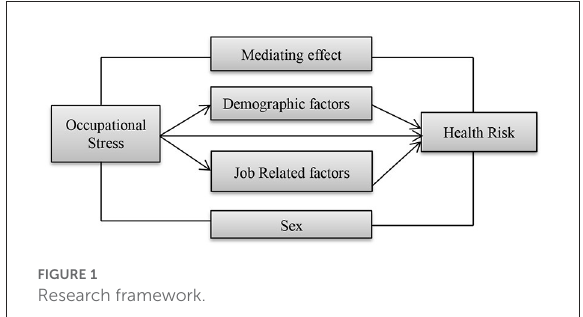
FIGURE1 Research